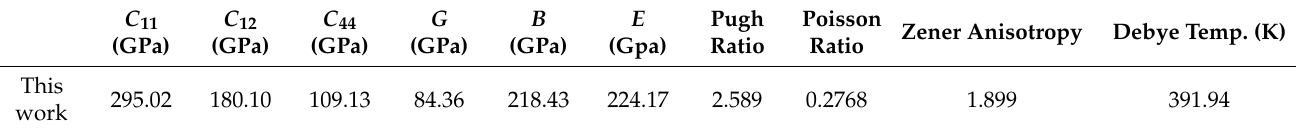
Table 2. Elastic constant and elastic moduli of